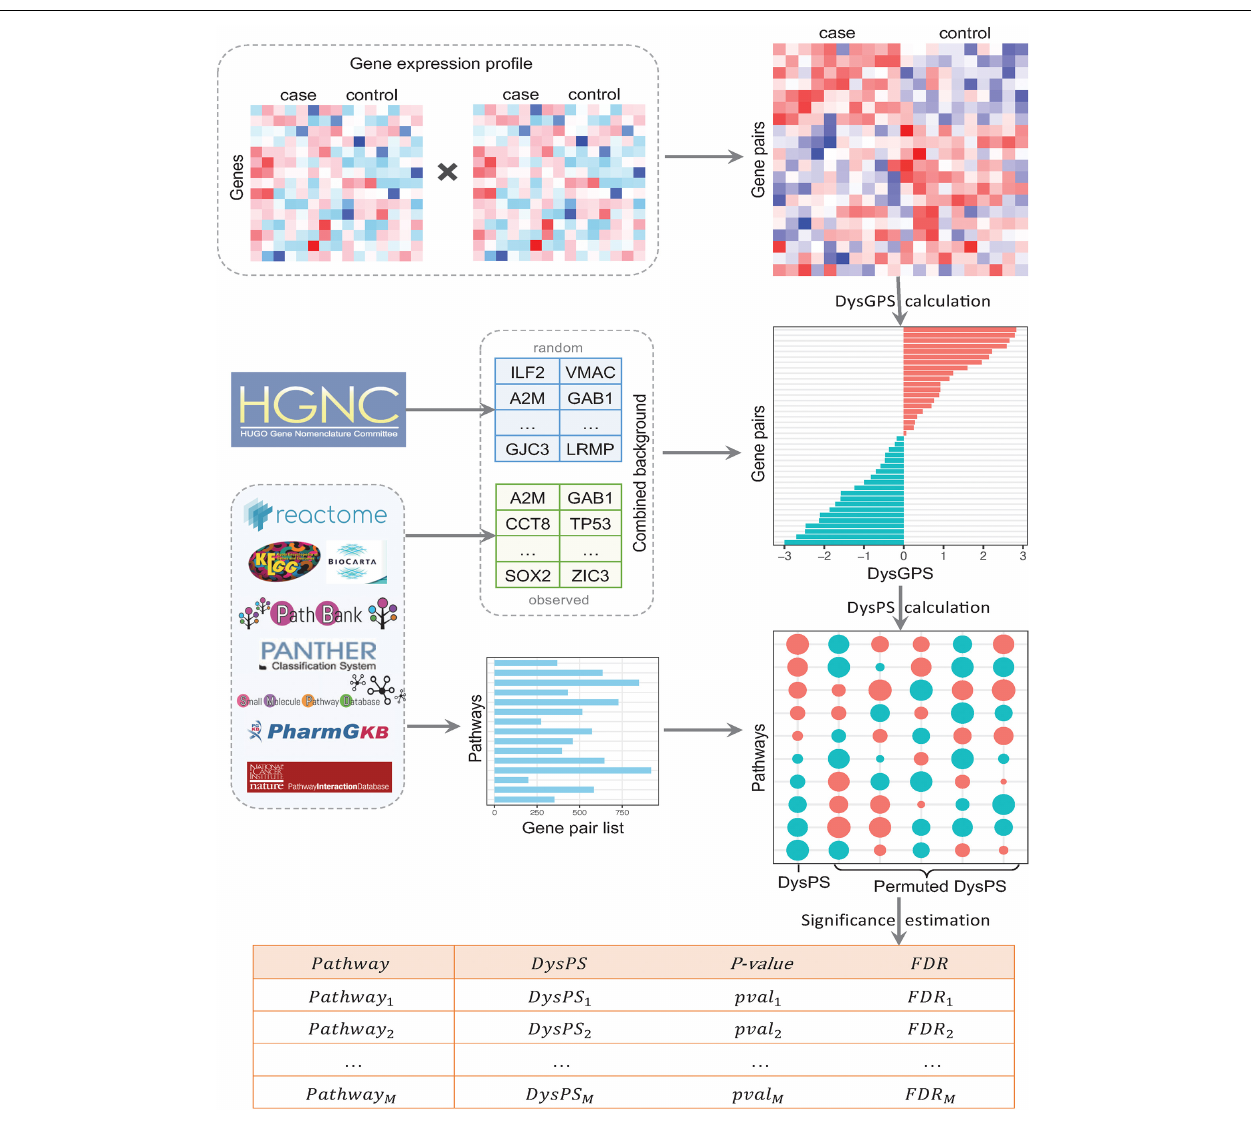
FIGURE 2 | The flowchart of DysPIA. In the left side, there are the input data, gene expression, combined background, and pathway gene list. From the gene expression data, the CILP-like gene pair scores are calculated, then the DysGPS and DysPS are calculated in the right side. The results are shown in the